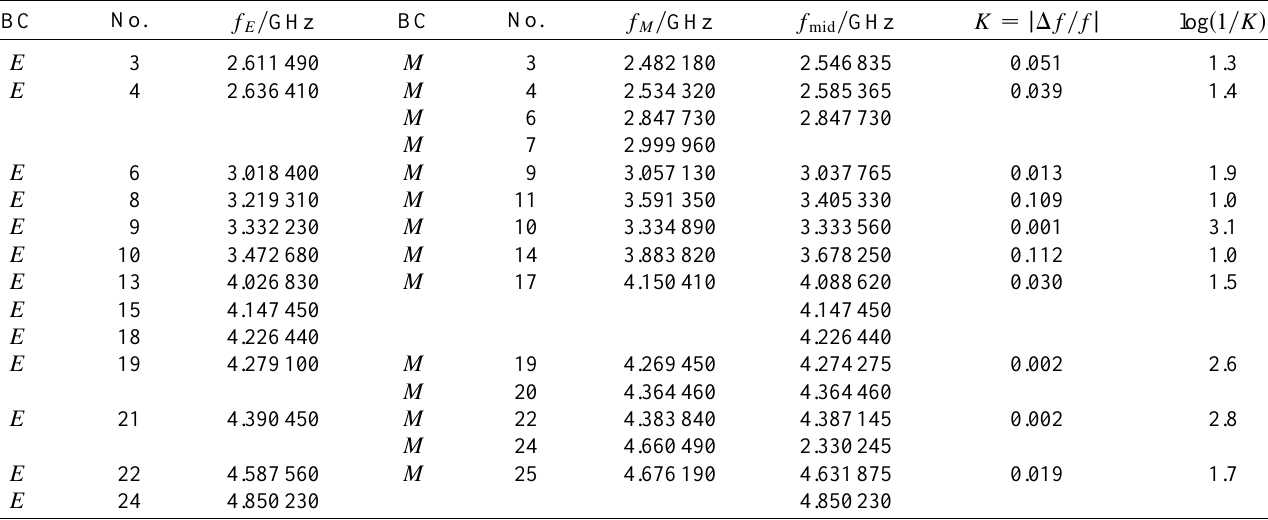
TABLE II. Eigenmodes in the model cavity and the influence of the chosen boundary condition at the beam tube. Only dipole modes are listed. Column “BC” denotes the type of the boundary condition at the beam tube ends ( M : perfectly magnetic conducting; E : perfectly electric conducting boundary condition). Modes that depend only weakly on the change in boundary condition are found. Other modes, which differ significantly in mode pattern and frequency between the two cases of beam tube boundary conditions, are not candidates for trapped modes.